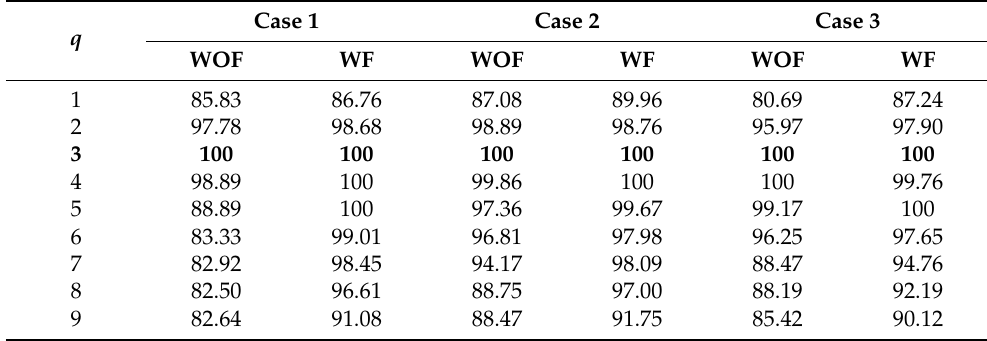
Table 3. The MeA (%) of the ANFIS-BFDM in the three data cases (see Table 2) depends on q (16) (WF: with the FIN; WOF: without the FIN; the bold: the results when q = q opt = 3).